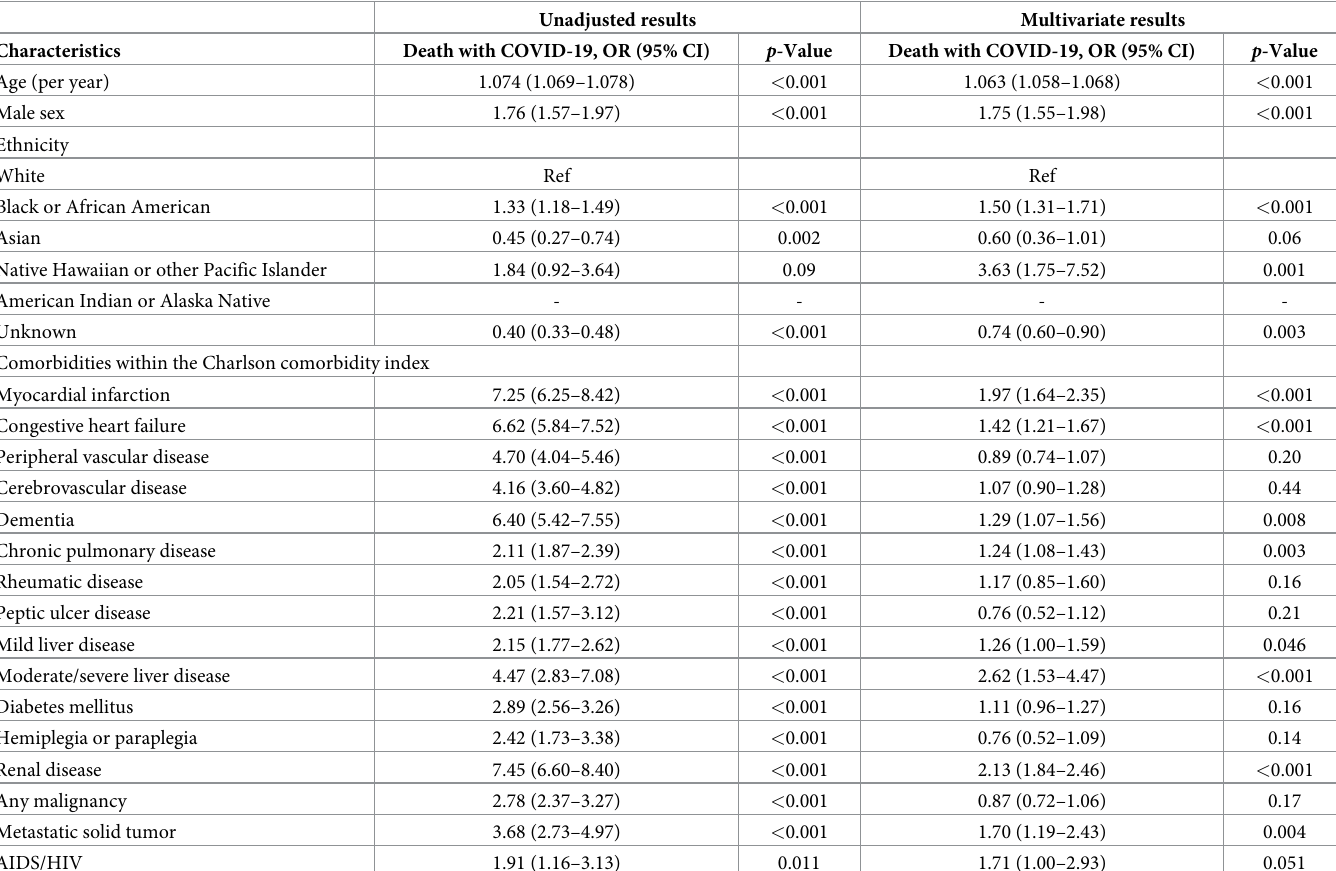
Table 2. Unadjusted and multivariate analysis of factors associated with mortality in adults with COVID-19 coded in the TriNetX research network as of May 26, 2020 ( n = 31,461). Unadjusted results Multivariate